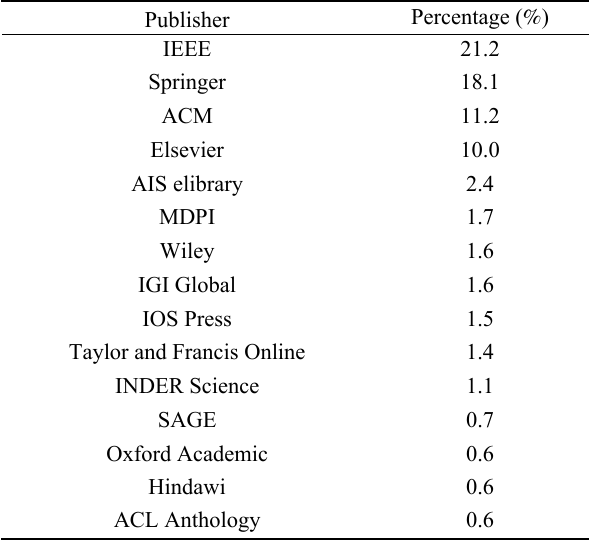
Table 3 First phase filtered dataset’s top 15 publisher